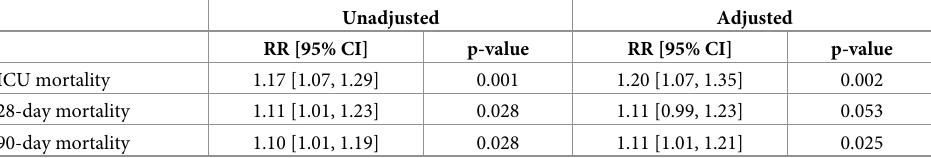
Table 4. Association between the 200-g increase in the quantity of diarrhea and secondary outcomes.